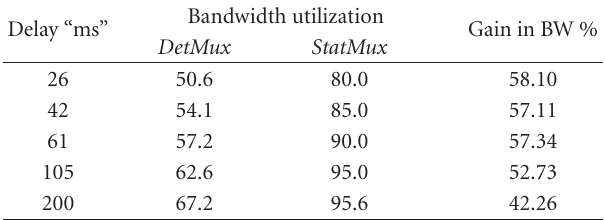
Table 1: Gain of StatMux in di ff erent bu ff ering delays when the bit streams are constrained to a bu ff ering delay of 3